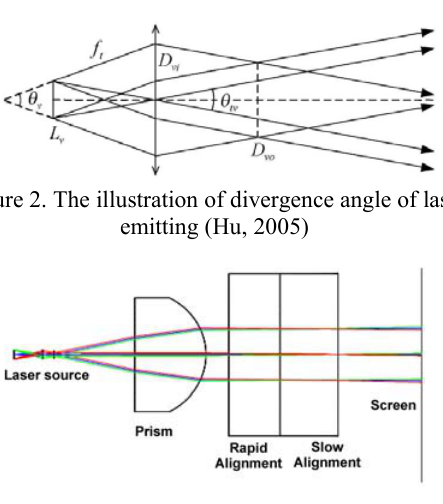
Figure 3. Simulated alignment of laser emitting system